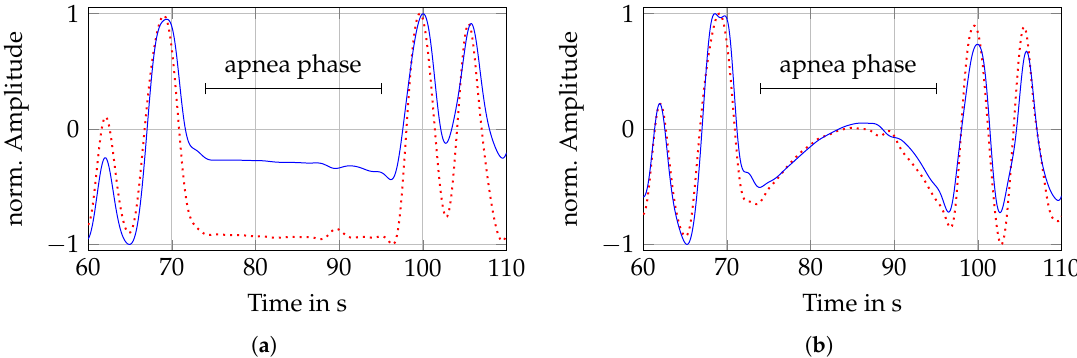
Figure 8. Comparison of low- and bandpass filtered respiration signals. ( b ) Reference (dashed) and radar (solid) respiration signal after applying a lowpass filter; ( b ) Reference (dashed) and radar (solid) respiration signal after applying a bandpass